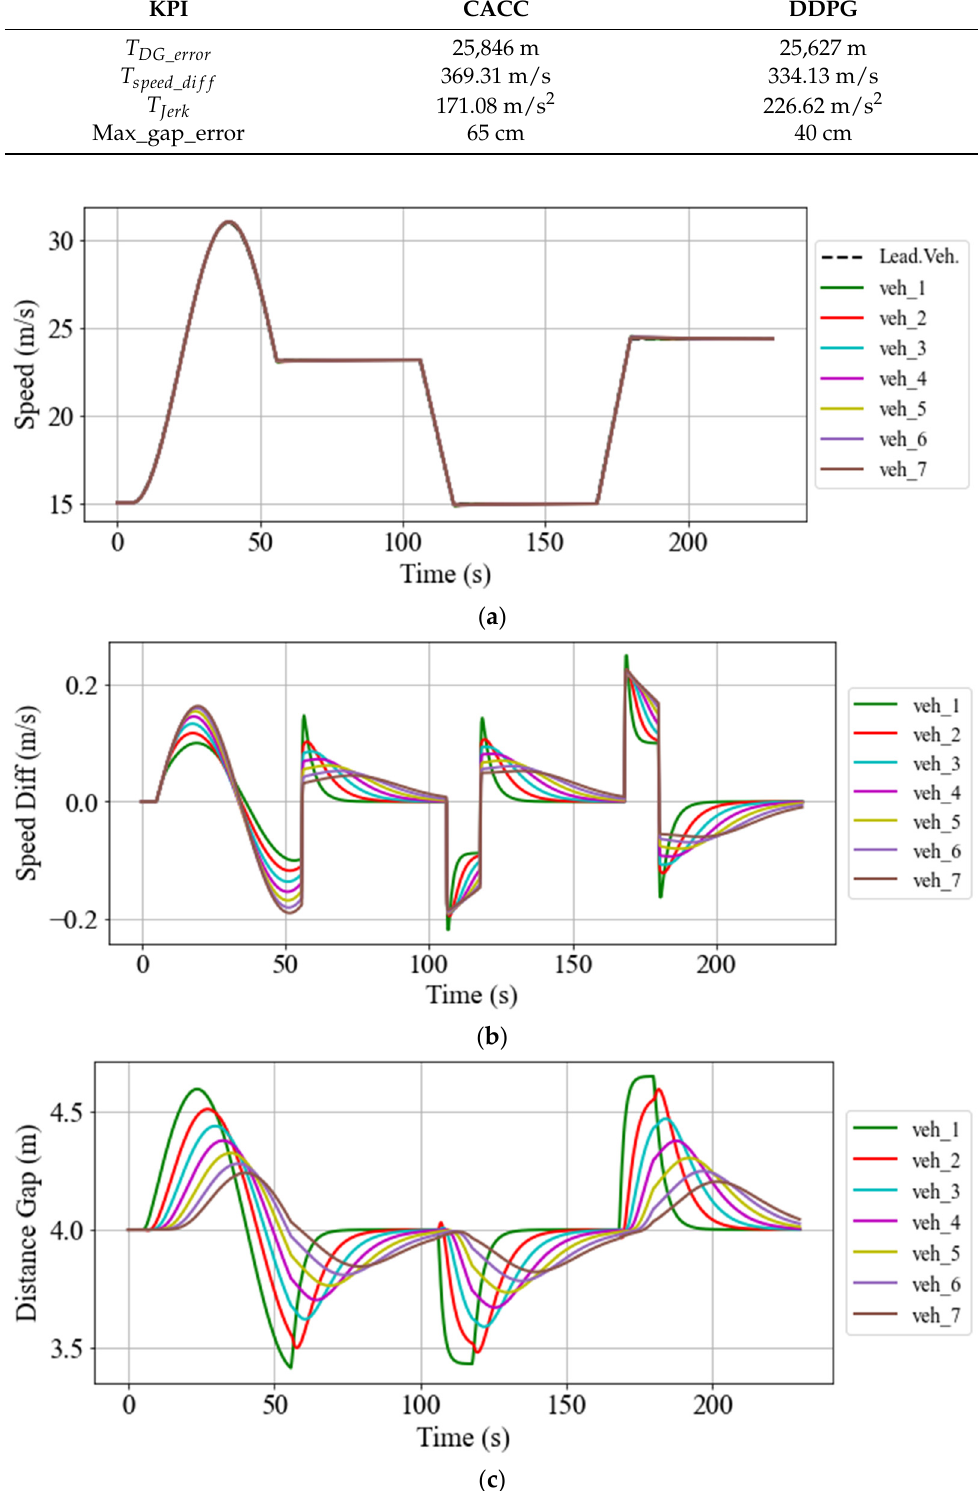
Figure 8. Variations in speed ( a ), speed difference ( b ), and distance gap ( c ) of participant vehicles in the CACC platoon system with respect to speed trajectory followed by the leading